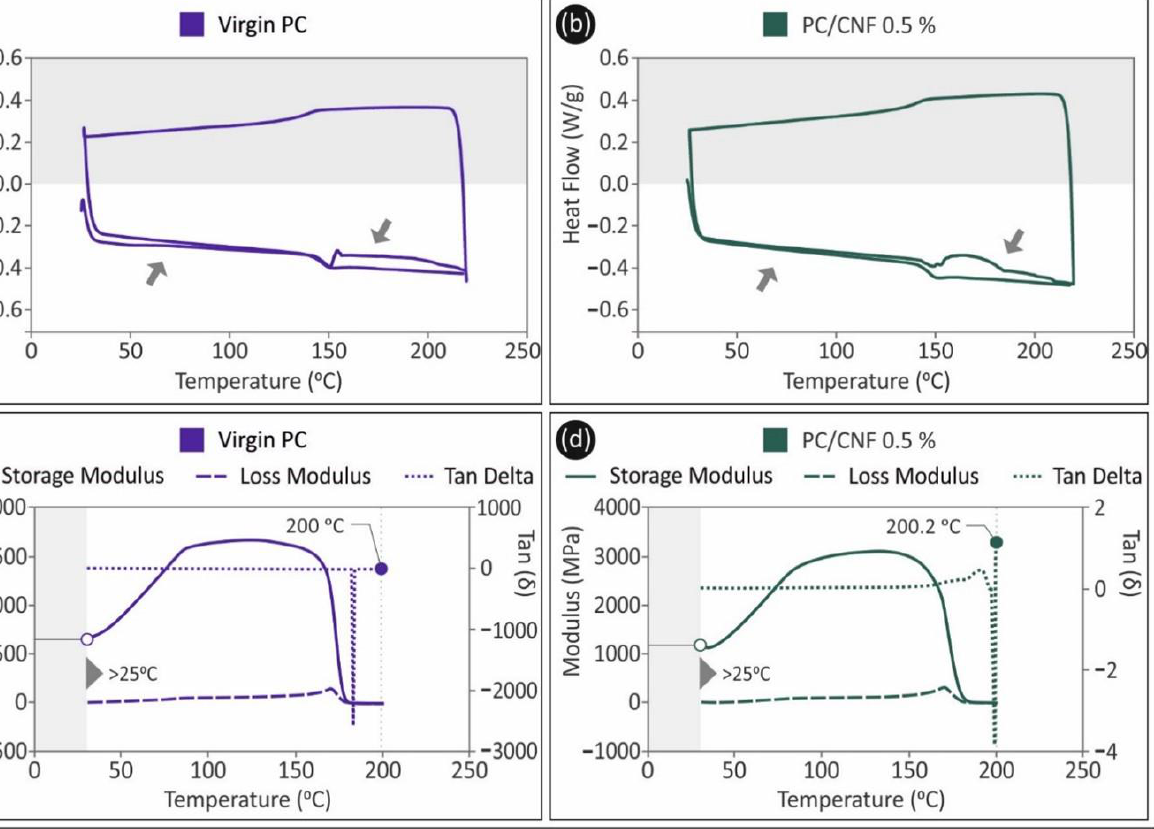
Figure 6. ( a ) DSC graph for the Virgin PC sample in the study, ( b ) DSC graph for the PC/CNF 0.5 wt.% sample in the study, ( c ) DMA graph for the Virgin PC sample in the study, ( d ) DMA graph for the PC/CNF 0.5 wt.% sample in the study.